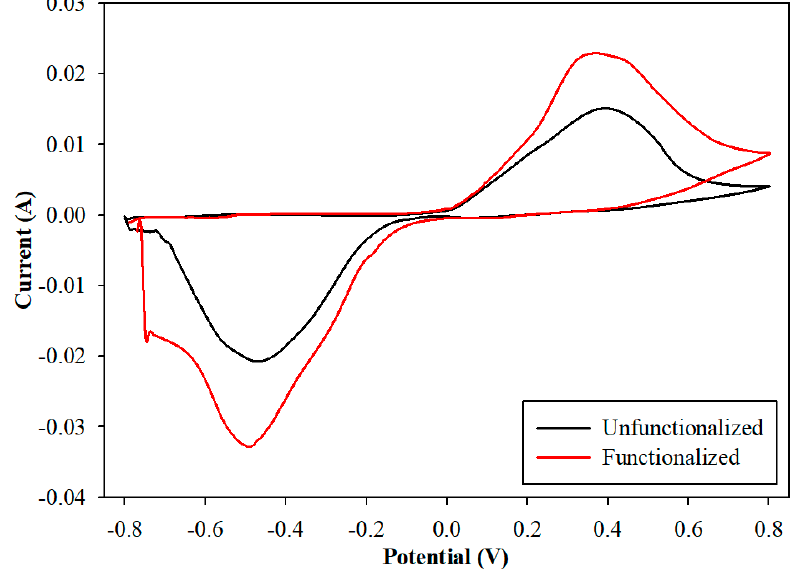
Figure 2. Cyclic voltammetry unfunctionalized vs. functionalized electrode in potassium hexacyanoferrate (III) solution.